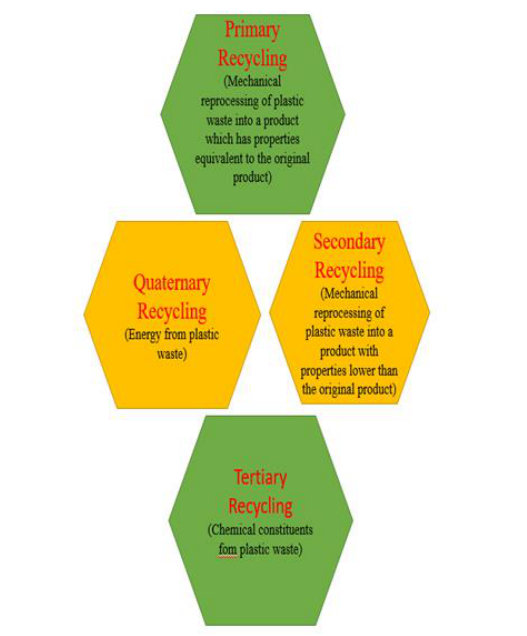
Figure 2. Recycling technologies for